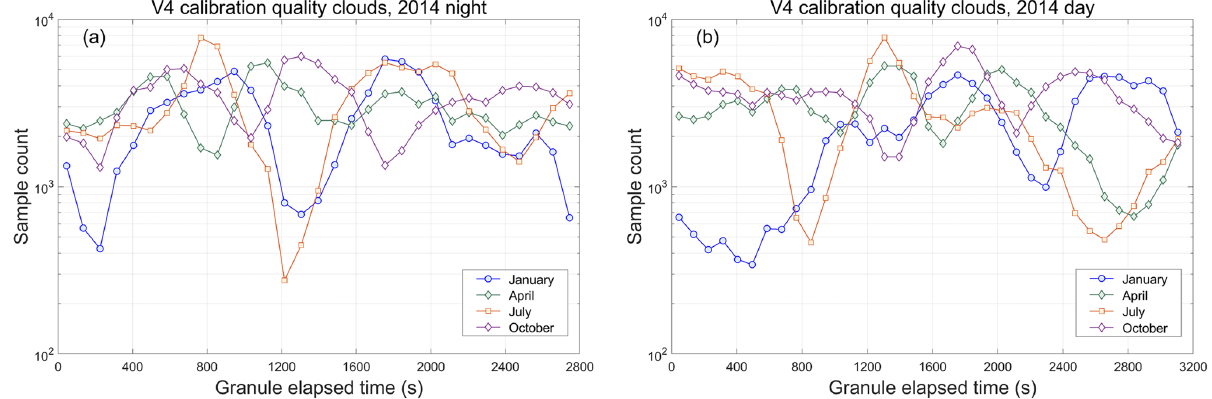
Figure 15. V4 calibration cloud occurrence frequency as a function of granule elapsed time (90s bins) for January, April, July, and Octo- ber 2014. Panels (a) and (b) show, respectively, nighttime data and daytime data.